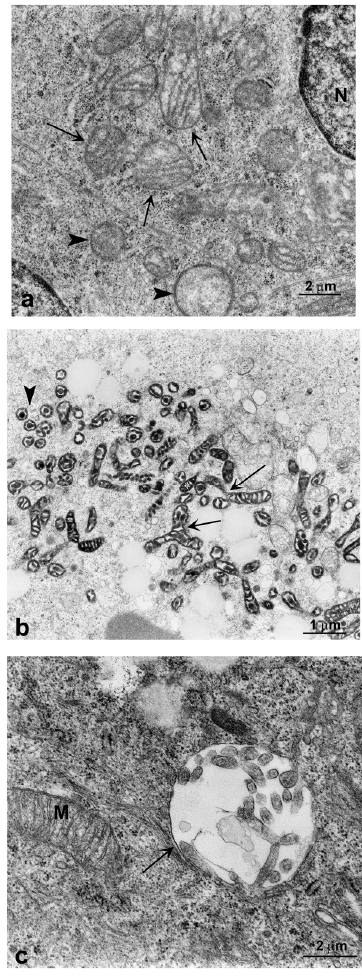
Figure 5. TEM images of autophagosomes in GO-treated SK-N-BE(2) cells: ( a ) SK-N-BE(2) cells at 48 h of GO treatment. Swollen mitochondria are visible. The matrix shows a decrease in electron density and an increase in volume. Sometimes the cristae appear disorganized (arrows). Disorganized mitochondria are also visible (arrowhead) (21,000×); ( b ) At 72 h of GO treatment the mitochondria are polymorphic, in condensed conformation (low energy state and high level of oxidative phosphorylation) with high electron density and decreased volume, intramembranes and intracristal space. Some fused mitochondria are visible (arrows) (11,500×); ( c ) Autophagosome (arrow) containing disorganized mitochondria (mitophagy) in SK-N-BE(2) cells at 72 h of incubation with GO (28,500×). N = nucleus; M = mitochondria. Images were taken by using a Philips CM-10 Trasmission Electron Microscopy as described under Materials and Methods.